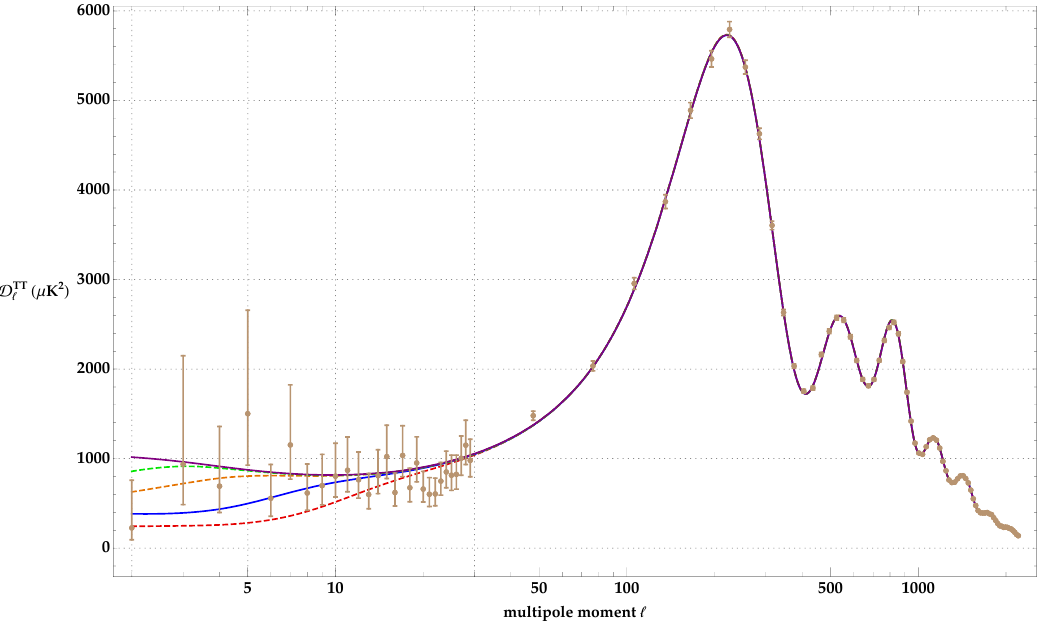
Figure 3 . The TT angular power spectrum for the Higgs in(cid:13)ation with various initial temperatures e T i at the CMB horizon scale. The best-(cid:12)t base-(cid:3)CDM model is given by the purple solid curve. Predictions of our model for various e T i are given by the red dashed curve (1 (cid:2) 10 (cid:0) 3 M P ), orange dashed curve (2 : 5 (cid:2) 10 (cid:0) 4 M P ), and green dashed curve (1 : 25 (cid:2) 10 (cid:0) 4 M P ). The blue solid curve depicts the best-(cid:12)t prediction of the Higgs in(cid:13)ation with an initial temperature e T i = 5 : 15 (cid:2) 10 (cid:0) 4 M P (or 3 : 62 (cid:2) 10 (cid:0) 3 M P ).